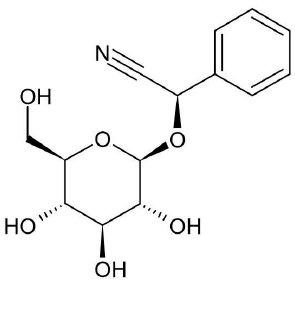
Figure 4. Chemical structure of prunasin—a cyanogenic glycoside isolated from A. vulgaris.